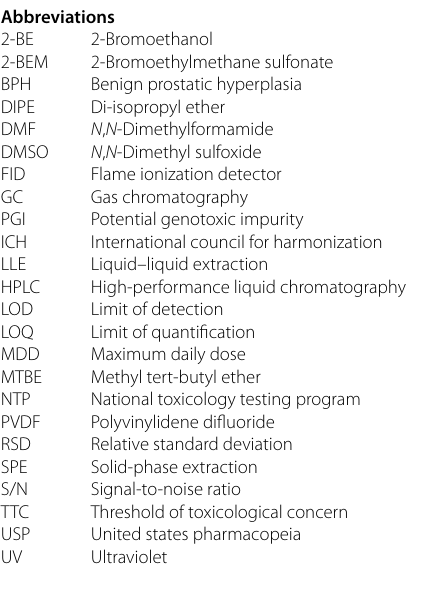
sion results. Table S4. Intermediate precision results. Table S5. Accuracy data for 2-BE. Table S6. Accuracy data for 2-BEM. Table S7. Summary of robustness results for 2-BE. Table S8. Summary of robustness results for 2-BEM